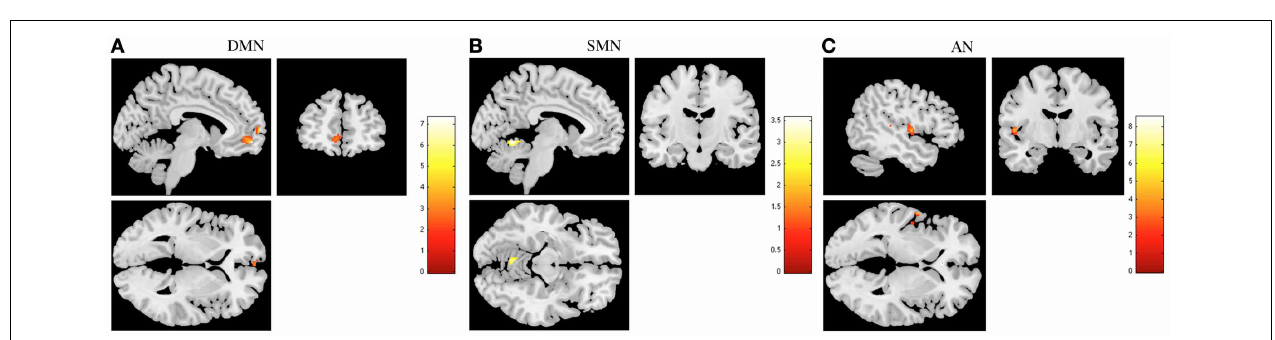
network (DMN) (D) . Ventral attention network (VAN) (E) displays increased functional connectivity in different regions both in stress recovered (orange) and in control (blue) participants. Results were extracted by independent component analysis and using two-sample t -tests, with results considered significant at a corrected for multiple comparisons p < 0 . 05 threshold.